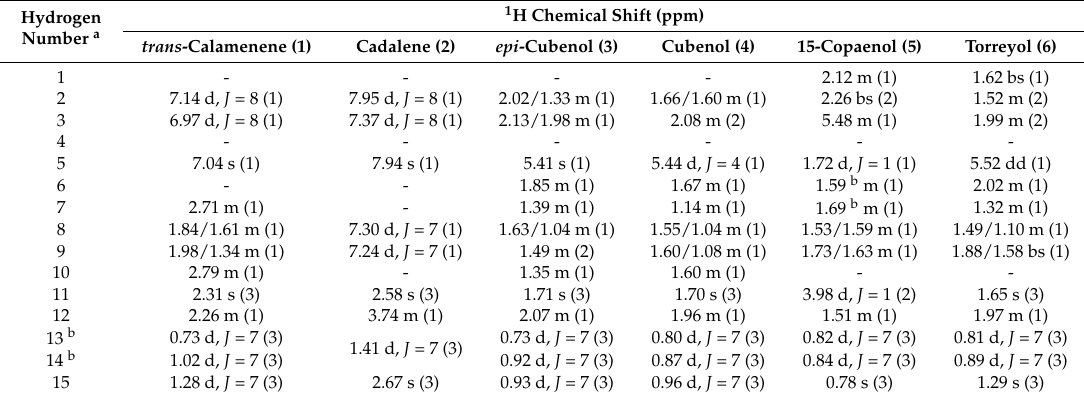
Table 3. 1 H-NMR data of sesquiterpenes isolated from P. uviferum (D. Don) Florin (400 MHz, CDCl 3